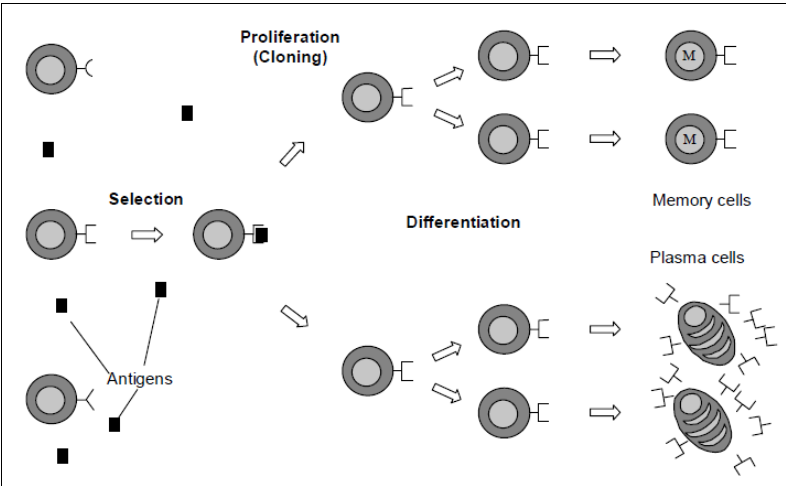
Figure 1. Principle of the immune-clonal selection